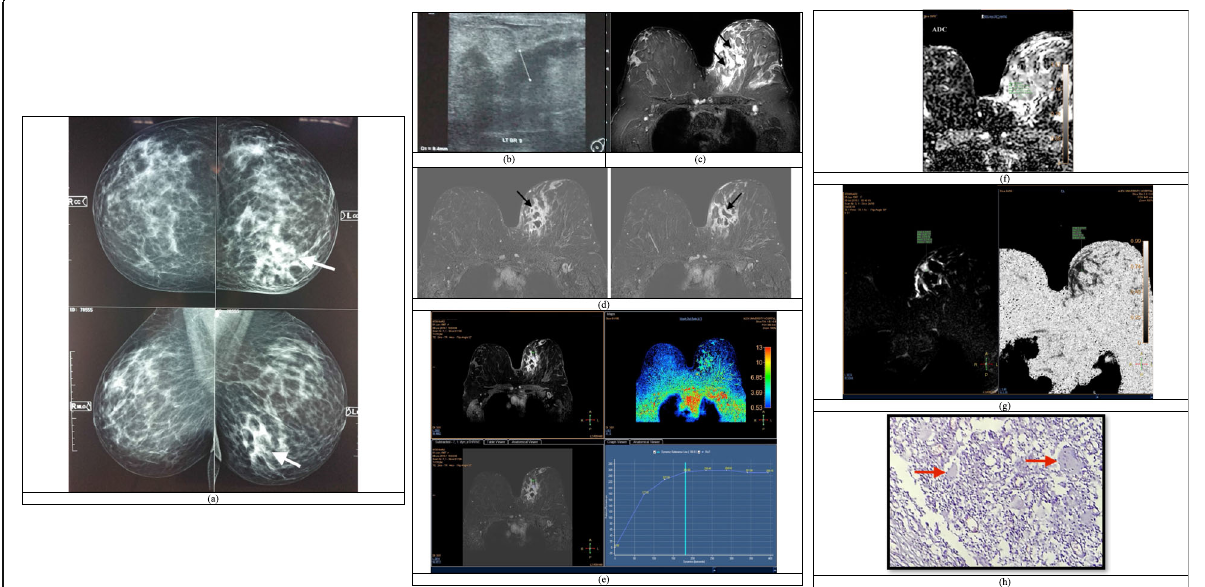
Fig. 4 33-year-old female presented with recurrent mastalgia and left nipple brownish discharge. a CC and MLO mammogram views showed focal asymmetry of left LIQ (arrow). b Ultrasound showed dilated ducts at left LIQ showing echogenic content with no solid intra ductal lesion. c Axial STIR showed focal hyper intense signal at left LIQ reflecting focal edema (arrows). d Dynamic THRIVE images showed dilated ducts showing enhancing thickened wall (black arrows) with non-mass clustered ring enhancement (white arrow). e Type II curve of dynamic enhancement. f DWI showed restricted diffusion, ADC = 0.9 × 10 − 3 mm 2 /s. g FA value 0.11 (< 0.2) matching with benign lesion, MRI final diagnosis was focal mastitis (BIRADS 4a). h TCNB revealed granulomatous mastitis showing multinucleated giant cells (arrows) surrounded by chronic